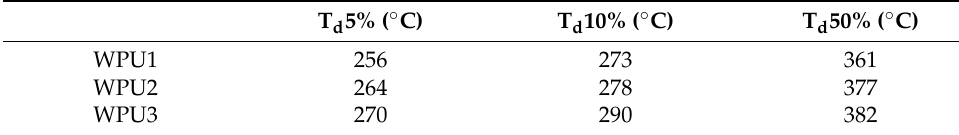
Figure 6. Stress-strain curve of WPU1, WPU2, WPU3.